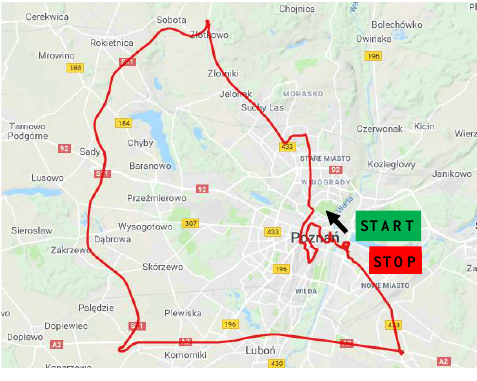
Fig. 5. Map of the road tests route Table 2. Test conditions for hybrid drive in two driving modes